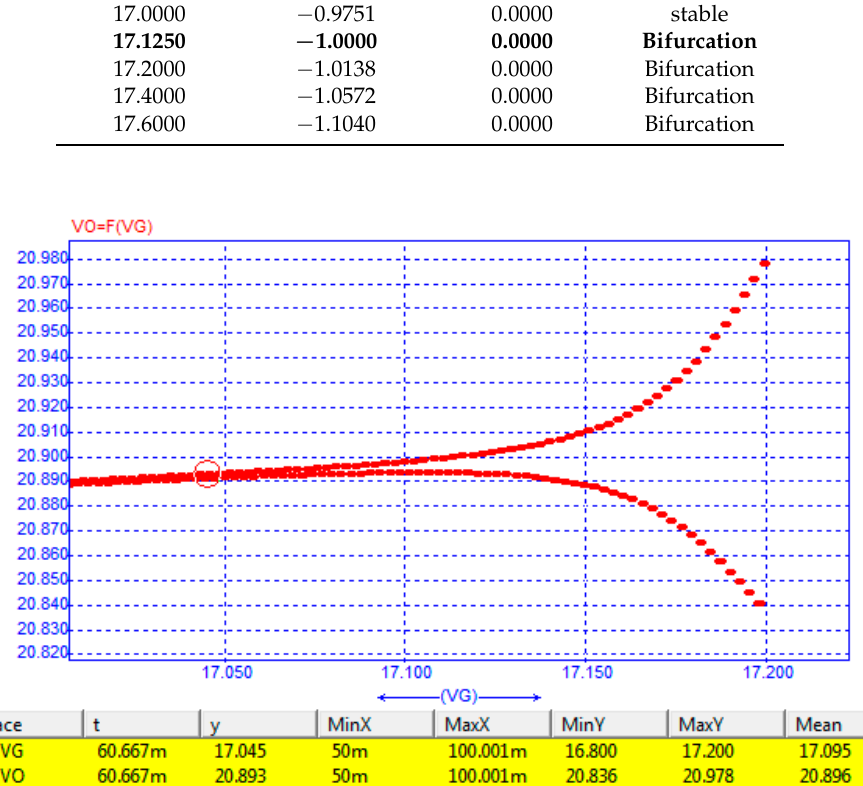
Figure 16. The simulated bifurcation diagram of the boost DCM converter: V out = f ( V g ).